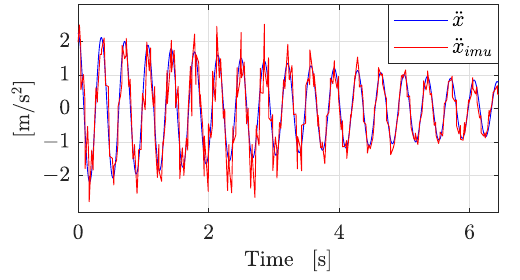
Figure 6: The simulated ¨ x c and measured ¨ x imu accel- eration of the camera due to decaying free vibration.